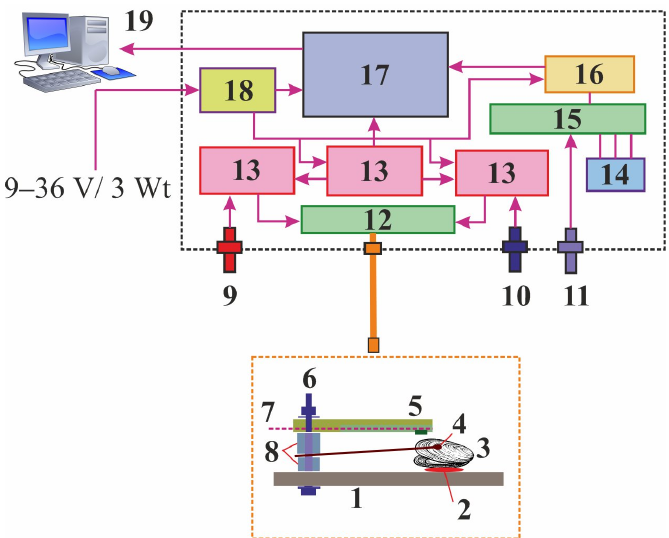
Figure 3. Scheme of the gaping activity registration system developed in T.I. Vyazemsky Karadag Scientific Station and Marine Hydrophysical Institute [58,60–62]. 1—frame substrate, 2—water-resistant adhesive sealant, 3—mussel, 4—flexible plastic batten with neodymium magnet, 5—analogous Hall sensor, 6—stainless fixture, 7—three-core cable for power and analog signal transmission, 8—polyamide inserts, 9—light sensor, 10—hydrostatic pressure sensor, 11—temperature sensor, 12—32-channel switch, 13—conversion and power circuit, 14—etalons, 15—4-channel switch, 16—conversion